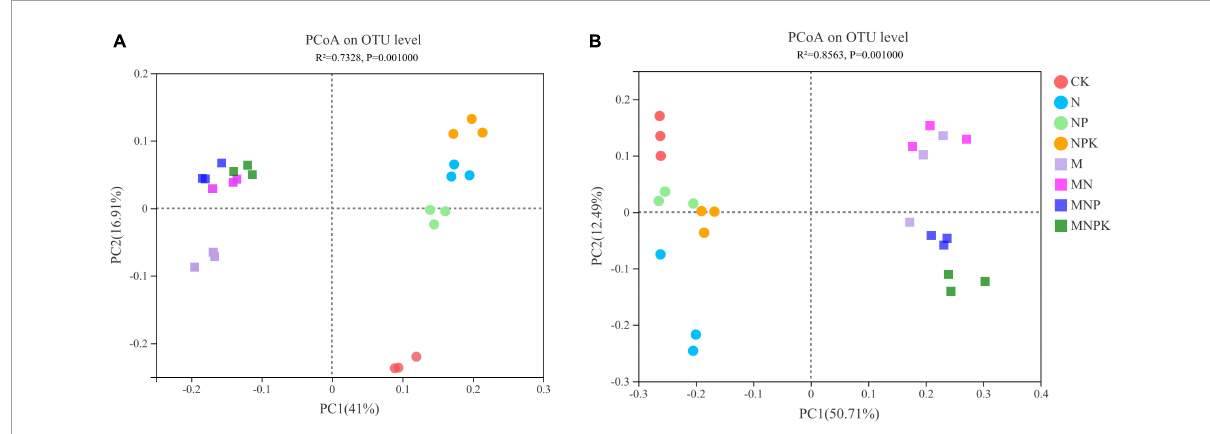
FIGURE2 Principal coordinate analysis (PCoA) of (A) bacterial community and (B) fungal